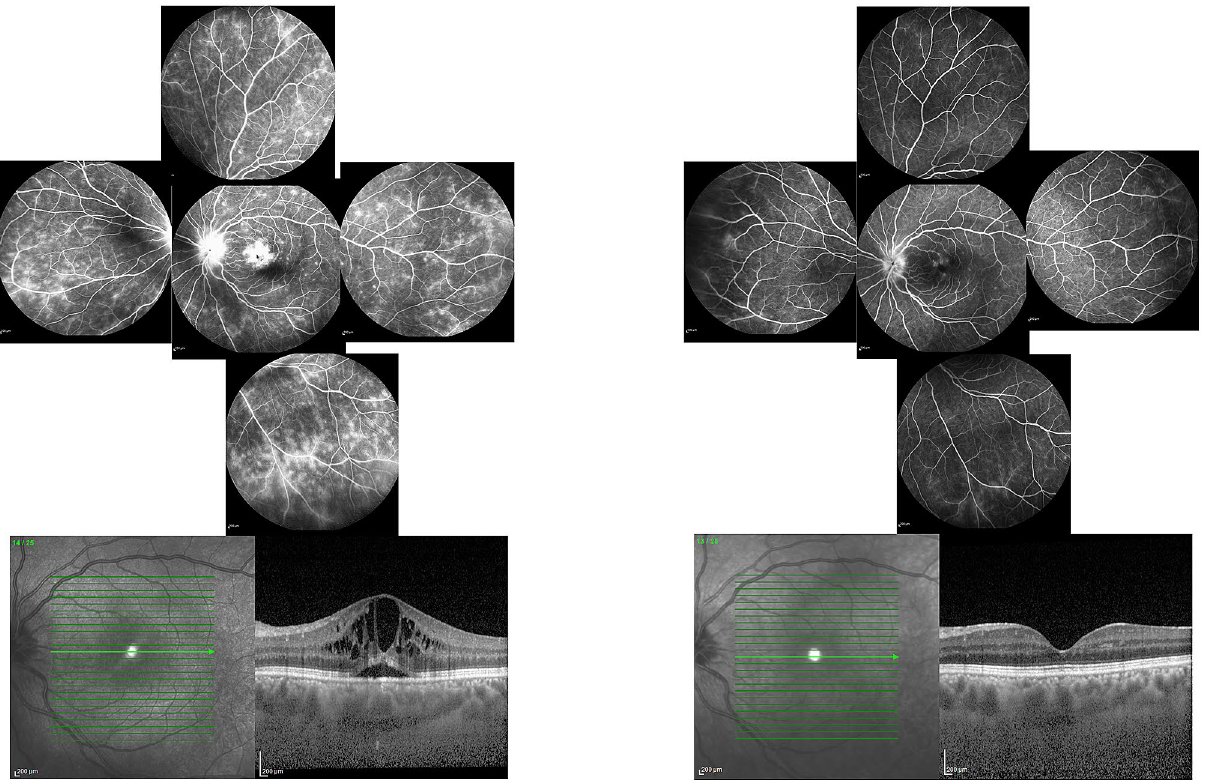
Figure 3. Representative baseline and follow up FA and OCT imaging: concurrent fluorescein angiography (FA) and OCT at baseline (left side) and 10.5 months later (right side) of the left eye of one of our patients with Behcet’s retinal vasculitis. FA is scored 25.5 at baseline and 12.5 at 10.5 months follow up. Both angiographic inflammatory activity in FA (top) and retinal thickness at the foveal area in OCT (bottom) have decreased substantially at 10.5 months follow up compared to